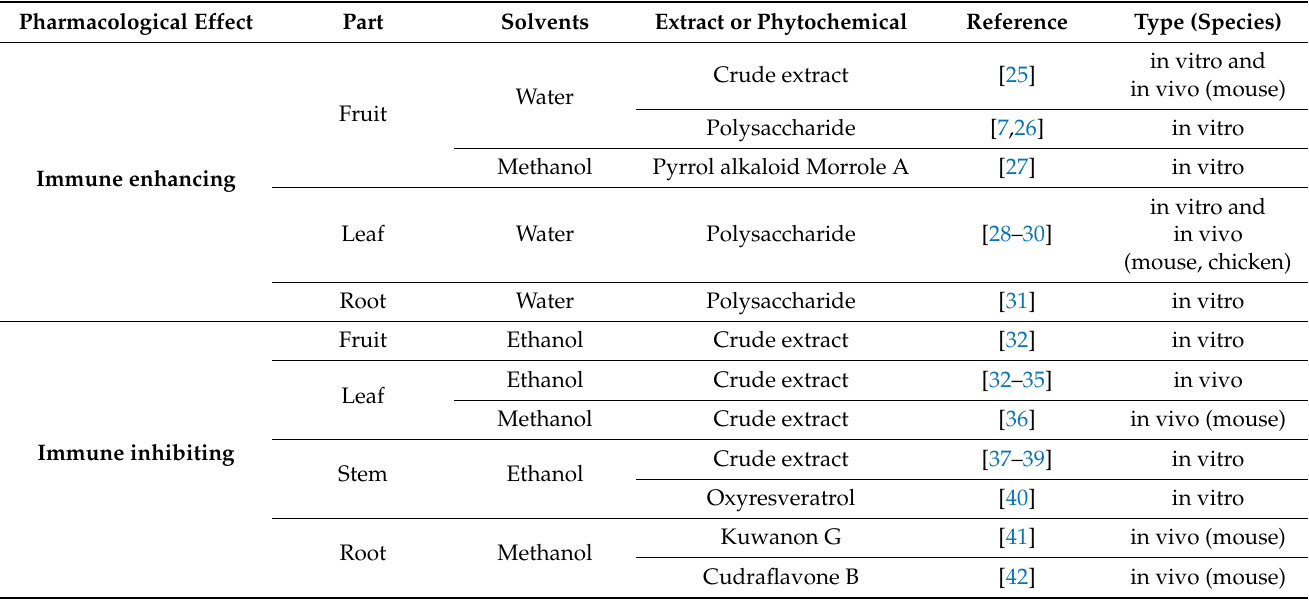
Table 2. Studies that investigated the pharmacological effects of phytochemicals present in M. alba L. extracts (grouped according to different parts or extract solvent types).